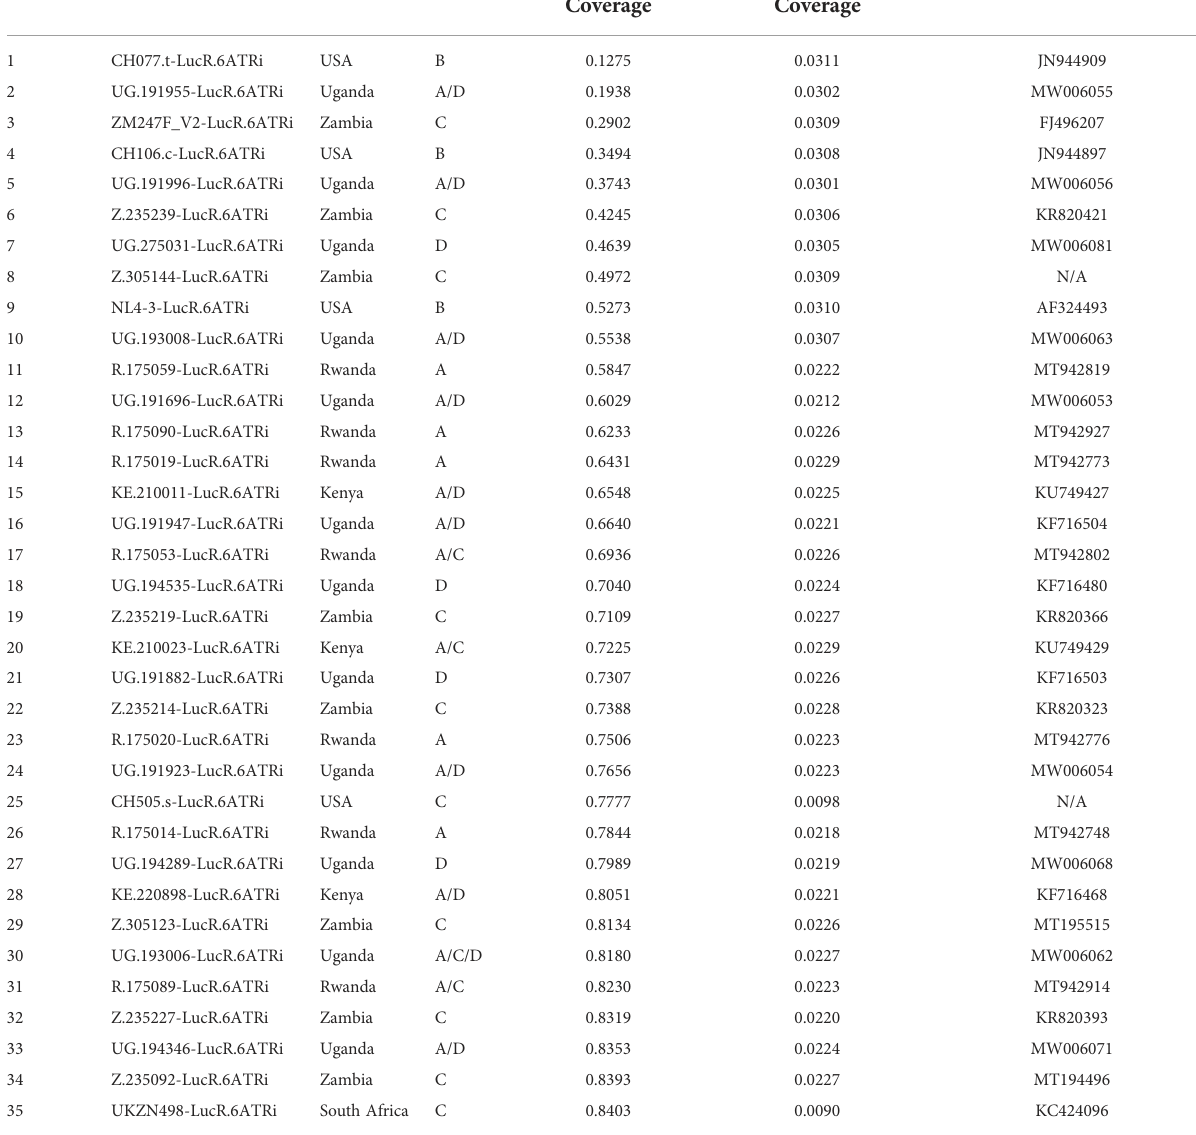
TABLE 1 Cumulative and individual epitope coverage score across the HIV-1